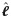
Evolution of ℓ^ on natural image patches when using different training setups.GRBM-196-196s were trained on whitened natural image data set with CD-1. The learning curves are the average ℓ^ on the test data over 10 trials and ℓ^ was estimated using AIS. “init. c = New” and “init. w = New” correspond to the initializations proposed in the previous section, and “init. w = 0.01” corresponds to an initialization of the weights to Gaussian distributed random values with standard deviation of 0.01. The learning rate for the variance parameter was set 100 times smaller than for the other parameters.